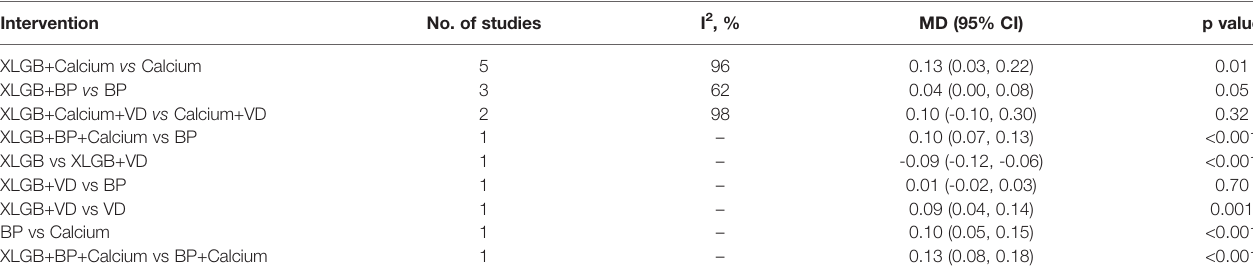
TABLE 2 | Traditional Meta-analysis of Lumbar BMD. Intervention